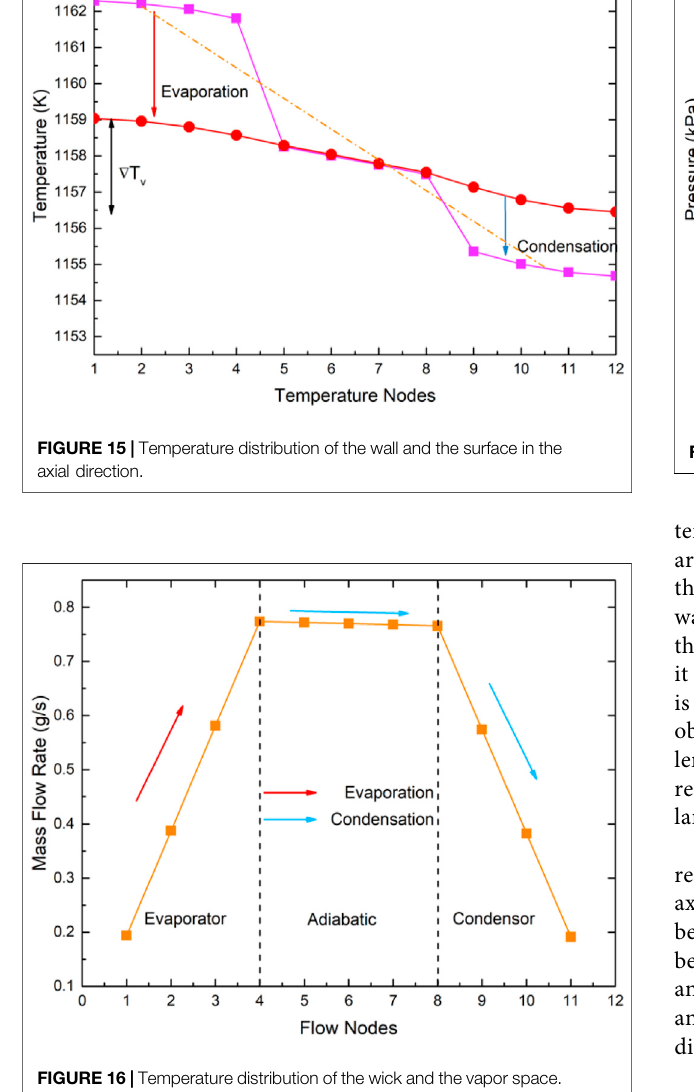
FIGURE 16 | Temperature distribution of the wick and the vapor space.